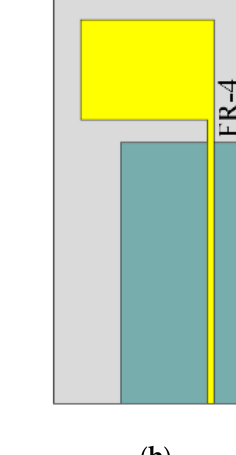
Figure 3. The reflection coefficient of the inverted L-shaped planar monopole antenna on a partial ground plane in vacuum and with FR-4 substrate.